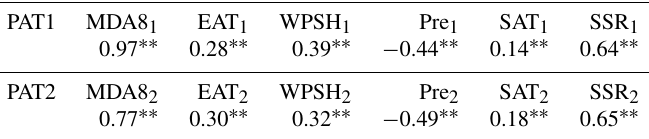
Table 1. Correlation coefficients between the time series of PAT1 (PAT2) and the key indices of atmospheric circulations and meteorological conditions. “ ∗∗ ” indicates that the correlation coefficients were above the 99% confidence